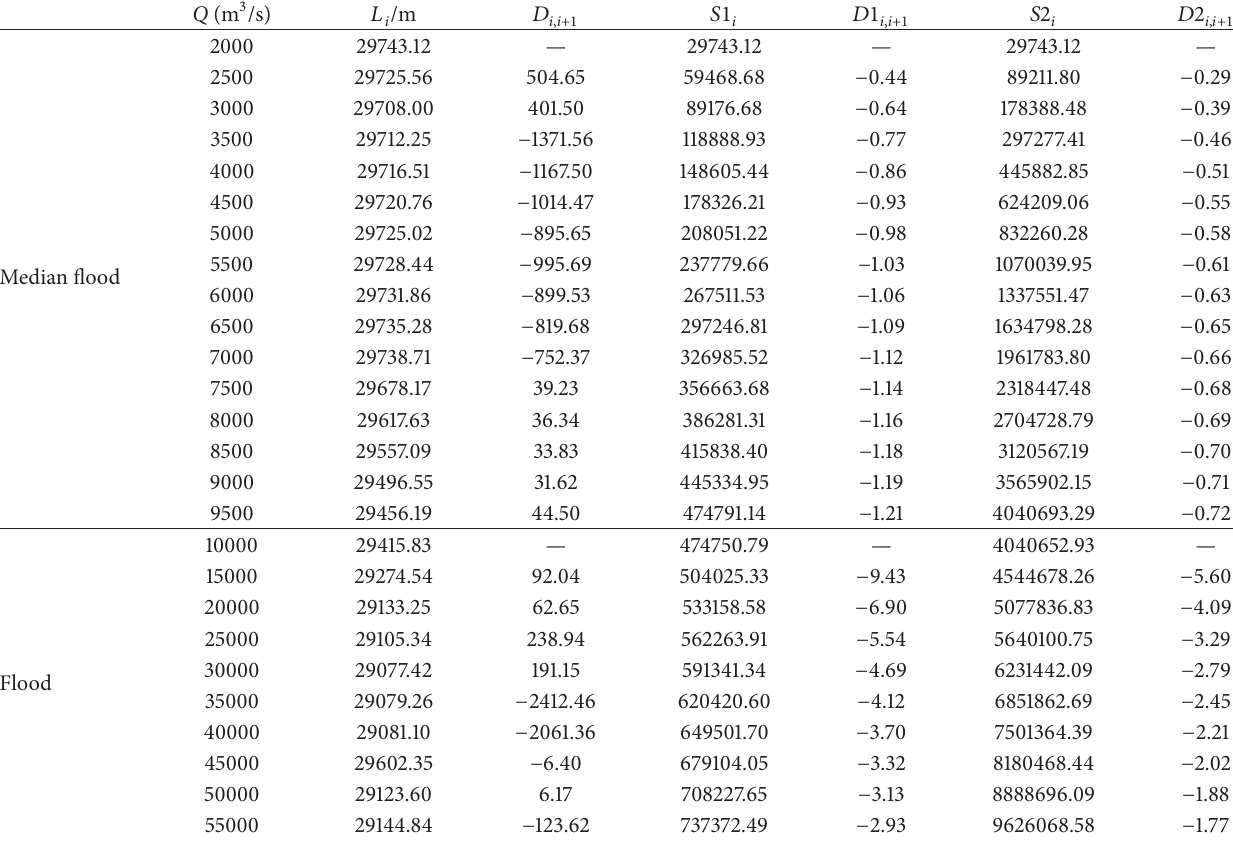
Table 3: Result of subdimensional fractal dimension of Chongqing city of Yangtze River left bank.